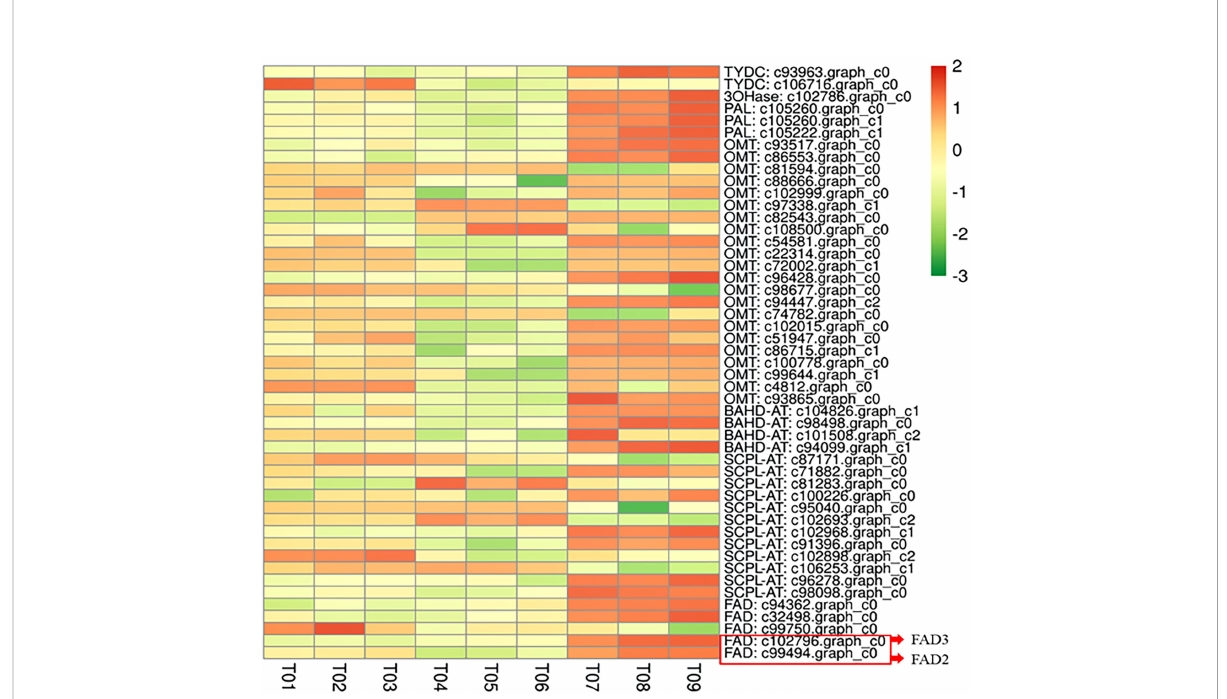
FIGURE 1 The expression levels of the DEGs related to the alkylamide biosynthesis pathway in Z. bungeanum . The highest expression of these genes was seen in Fugu (T07-T09), followed by Hancheng variety (T01-T03), with the lowest being in Fengxian